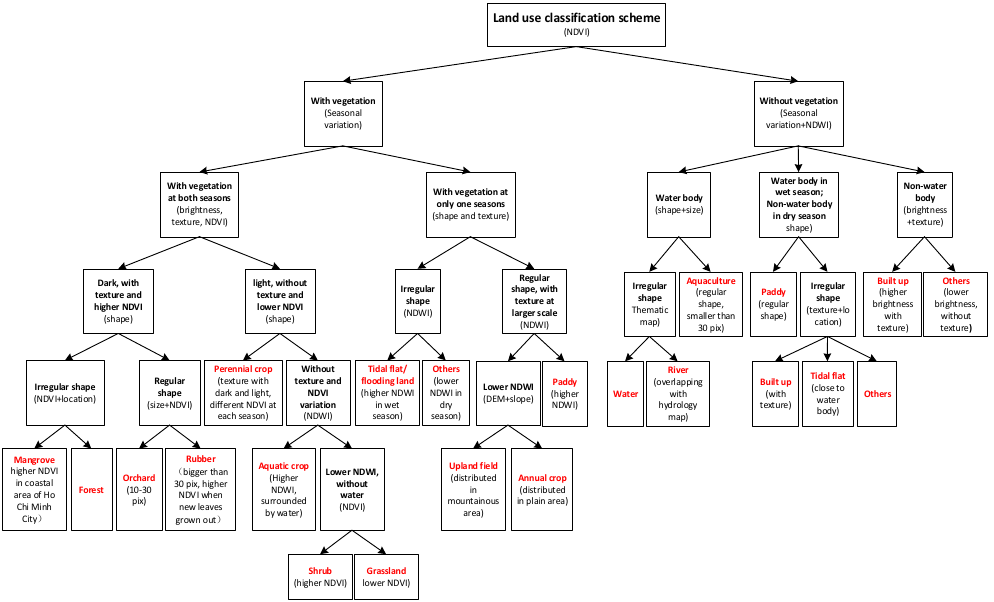
Figure 3. Land use classification scheme for major cities in the GMS. Words in parentheses are classification criteria, words in bold fonts are classification results using criteria above them. NDVI, Normalized Difference Vegetation Index [39,40]; NDWI, Normalized Difference Water Index [41]. Land use types are highlighted in red